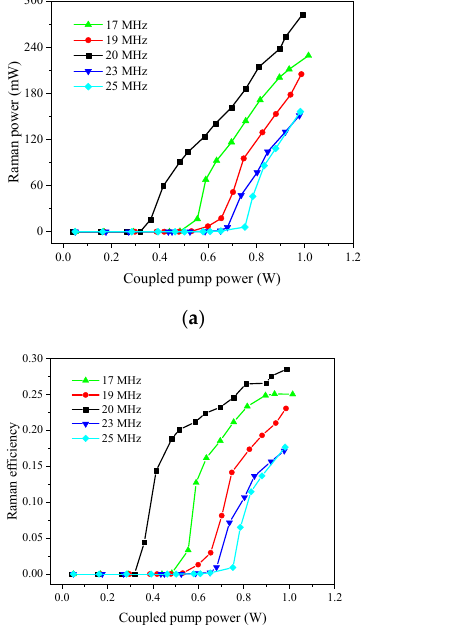
( c ) The Raman efficiency of different pulse widths. ( d ) The Stokes pulse energy with coupled pump